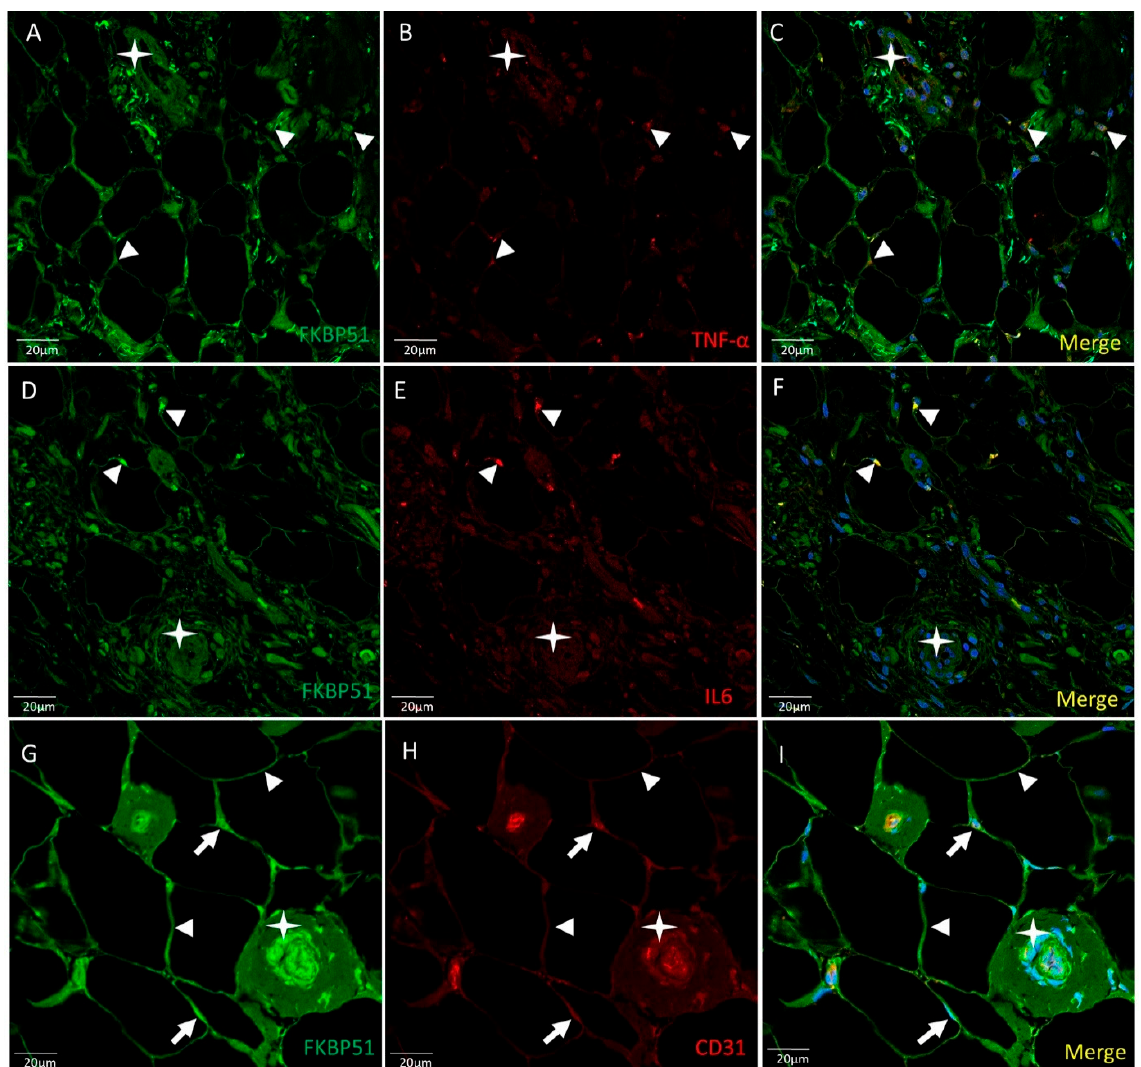
Figure 4. Double immunolabelling for FKBP51 and inflammation markers TNF- α and IL6 and CD31 in Hoffa’s fat pad tissue sections from a patient with knee OA grade IV. Merges also contain DAPI staining. (( A – C ): FKBP51 signal is located at the cytosol and nuclei of all adipocytes. TNF- α staining in adipocytes and tissue around colocalized with FKBP51 (arrowheads). ( D – F ): IL6 in adipocytes and tissue around. A small number of cells showed a high staining level colocalized with FKBP51 (arrowheads). Stars are placed in a vessel. ( G – I ): FKBP51+/CD31+, immunofluorescence for FKBP51 in cytoplasm of adipocytes (arrowheads) and CD31 mainly around the nuclei (arrows) and in endothelial cells of small